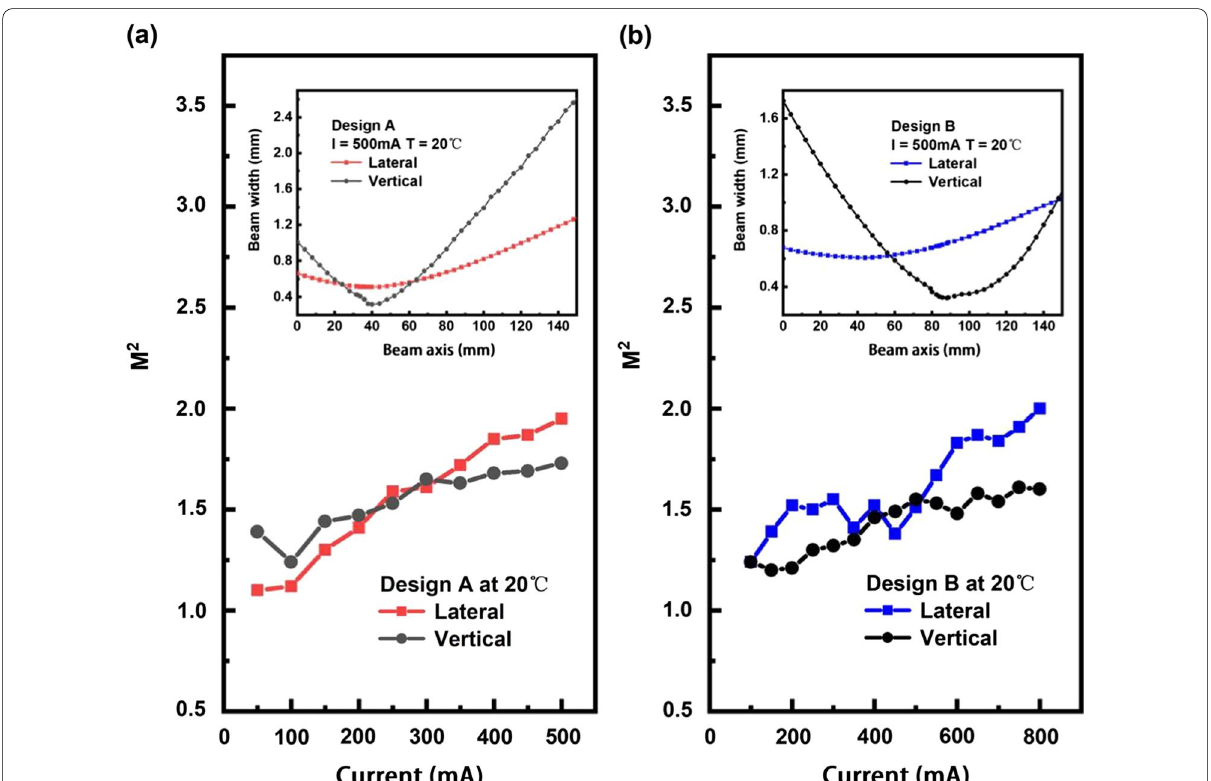
Fig. 6 Measured beam quality factor M 2 values in the lateral and vertical directions versus injection current: a Design A and b Design B. The insets present the measured beam width in the lateral and vertical directions versus the beam axis obtained at a 500 mA injection